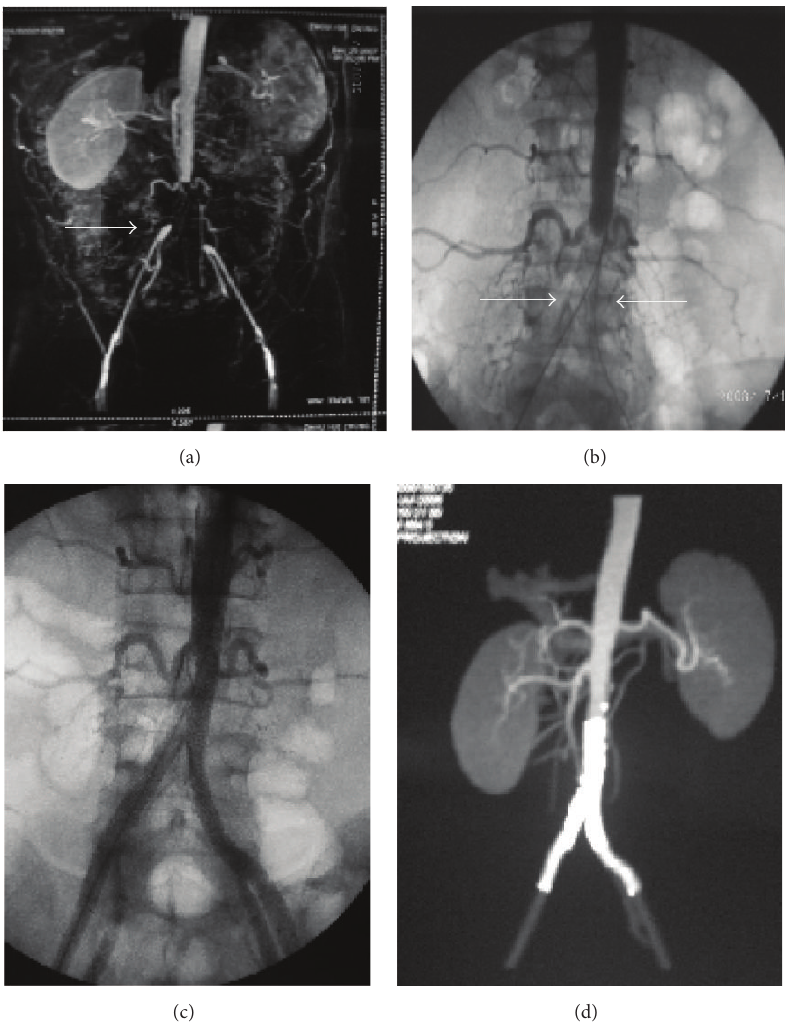
Figure 2: Stenting for a male PAD patient of 46 years. (a) CTA showed aorta-iliac artery occlusion lesions (arrow). (b) Two guide wires pass to aorta-iliac artery from bilateral femoral artery (arrows). (c) After dilation by balloon, Kissing-stents placement involving the distal aorta and bilateral common iliac is performed. (d) Excellent result.